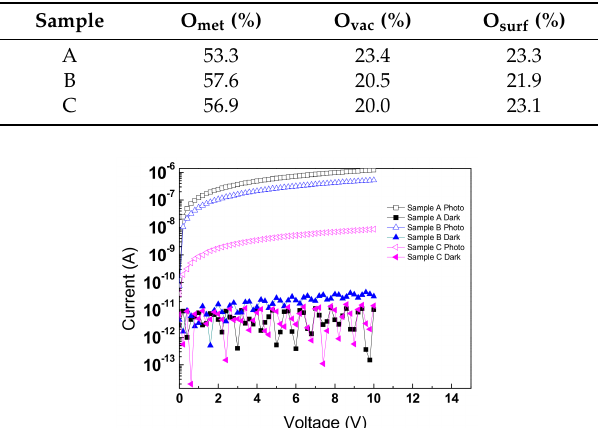
Figure 3. XPS O 1 s spectra of GaZTO thin films with different experimental conditions: ( a ) Sample A; ( b ) Sample B; and ( c ) Sample C. Table 2. Relative peak area ratio of the GaZTO thin films.